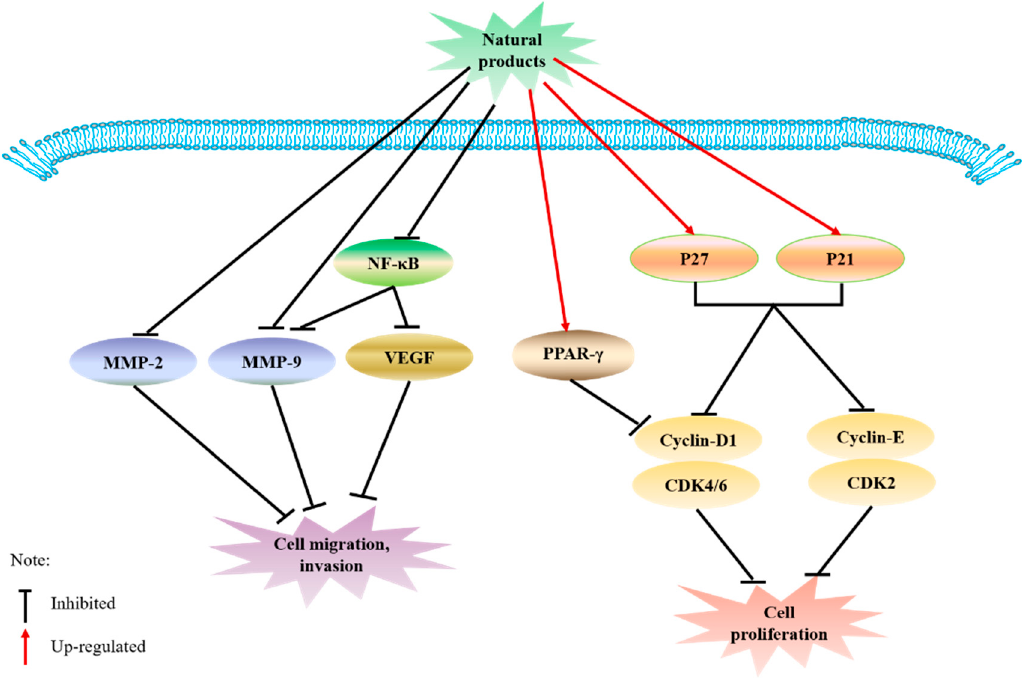
Figure 2. Mechanism of migration and proliferation.